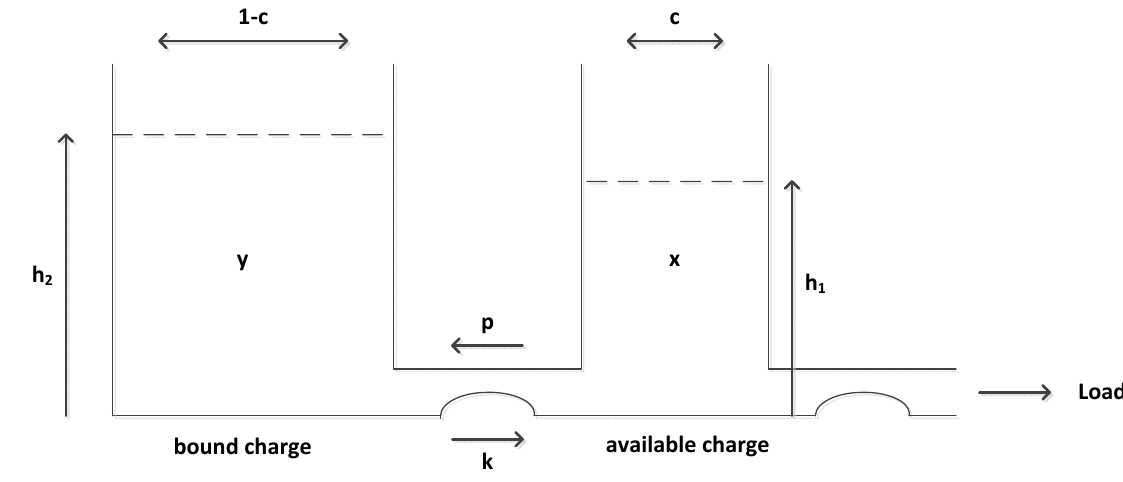
Figure 1. The two-well kinetic battery model